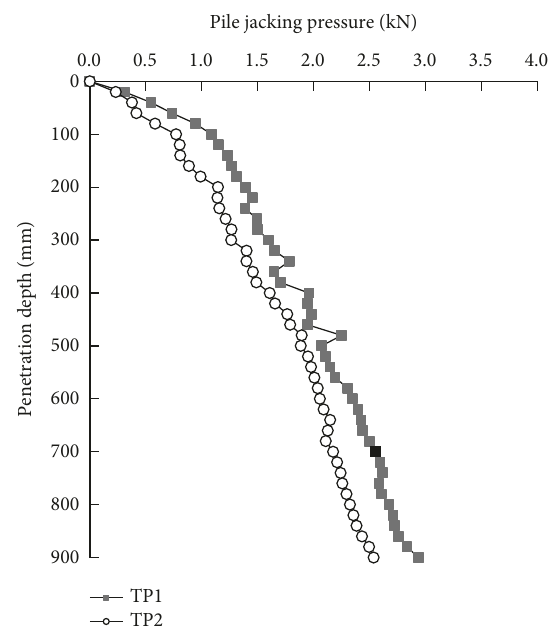
Figure 3: Pile driving pressure for open-end and closed-end